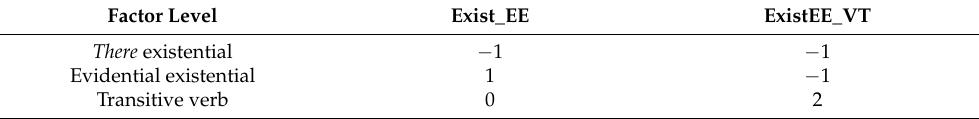
Table A15. Contrasts for evidential existentiality norming study Response factor (Helmert coding).